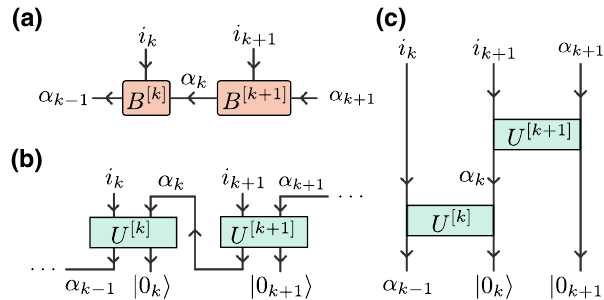
FIG. 8. (a) Two tensors in right orthogonal form. (b) A right orthogonal MPS can be directly mapped to a quantum circuit. (c) The corresponding quantum circuit, where the gates act sequentially from the first to the last qubit.